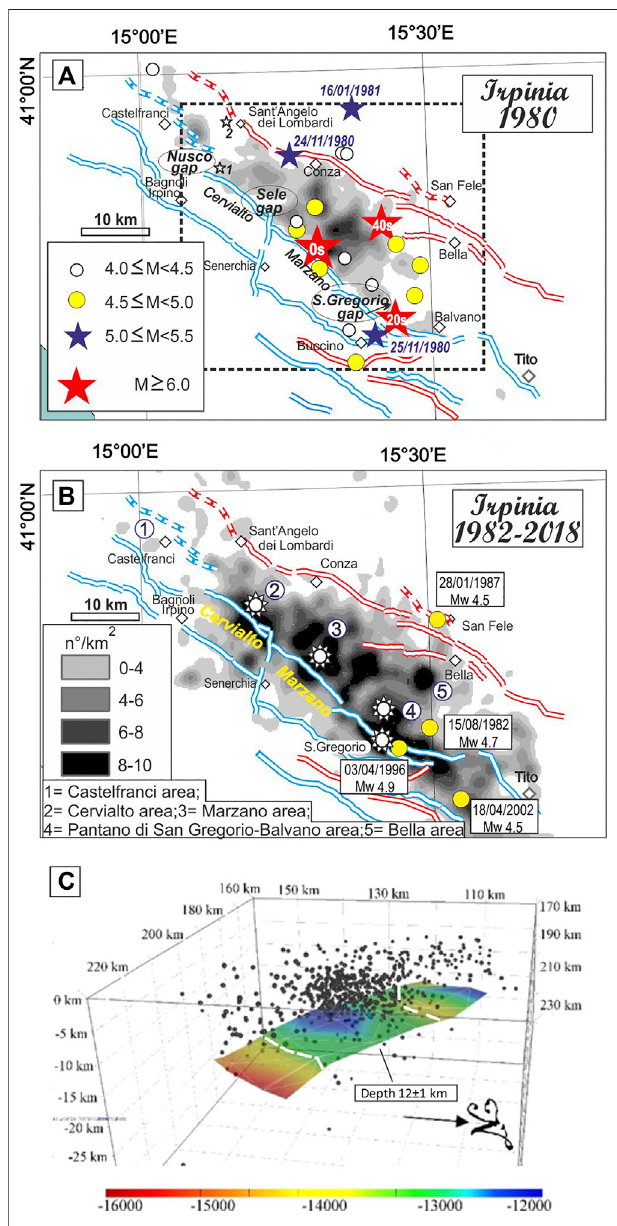
FIGURE 9 | Instrumental seismicity of the study area from 1980 to 2018. (A) Seismicity distribution of the Irpinia 1980 seismic sequence (M w 6.9, Io X MCS) from November23,1980toDecember31,1981.Themaineventsepicentres(redstars)are fromAmorusoetal.,(2005)andAmorusoetal.,2011,theothersigni fi cantevents are from Montone and Mariucci 2016, Italian CMT (Pondrelli et al., 2006) and some unpublisheddata.Thedensitycontourlines(numberofearthquakespersquarekilometer) are referred to the aftershocks (1.0 ≤ M L ≤ 4.0) occurred from the fi rst to the 15th Decemberof1980andrelocatedbyAmorusoetal.,(2011).Thetwosmallwhitestars,1 and2,aretheepicentersoftheNusco(April15,2020,ML3.3)andRoccaSanFelice(July 6,2020,M L 2.7)recentsmallevents,respectively. (B) Seismicitydistributionfrom1982to 2018obtained compiling theItalian SeismicCatalogueCSI (Castello etal.,2006) and all theevents(0.3 ≤ M L ≤ 5.1)listedintheItalianSeismologicalInstrumentalandParametric database(ISIDe,workinggroup2016).Thewhitestarsrepresenttheseismicityclusteras in reported in Stabile et al., 2012. (C) Base of the seismogenic layer computed for the studyareaandusedforthesourcemodelreconstruction,obtainedwithDeLandroetal., 2015 relocated seismicity. The white line represents the reliable curve.